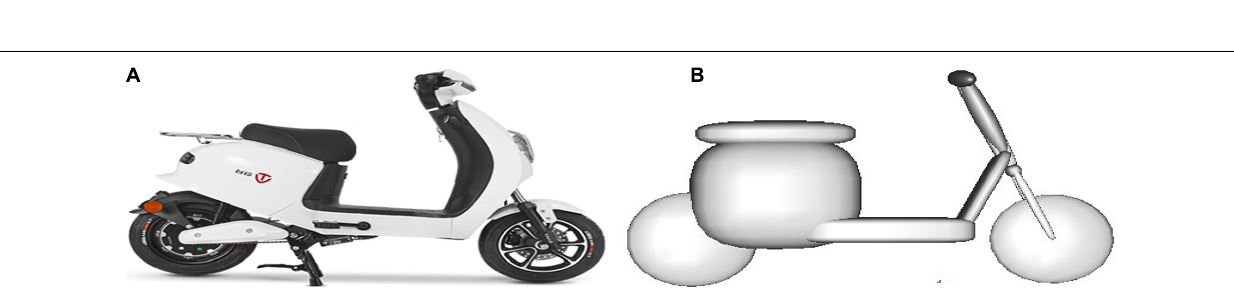
FIGURE 4 | Modeling of the electric two-wheeler involved in Case 31: (A) the ETW in the real-world accident and (B) MB model of the ETW. ETW, electric two-wheeler; MB, multibody.